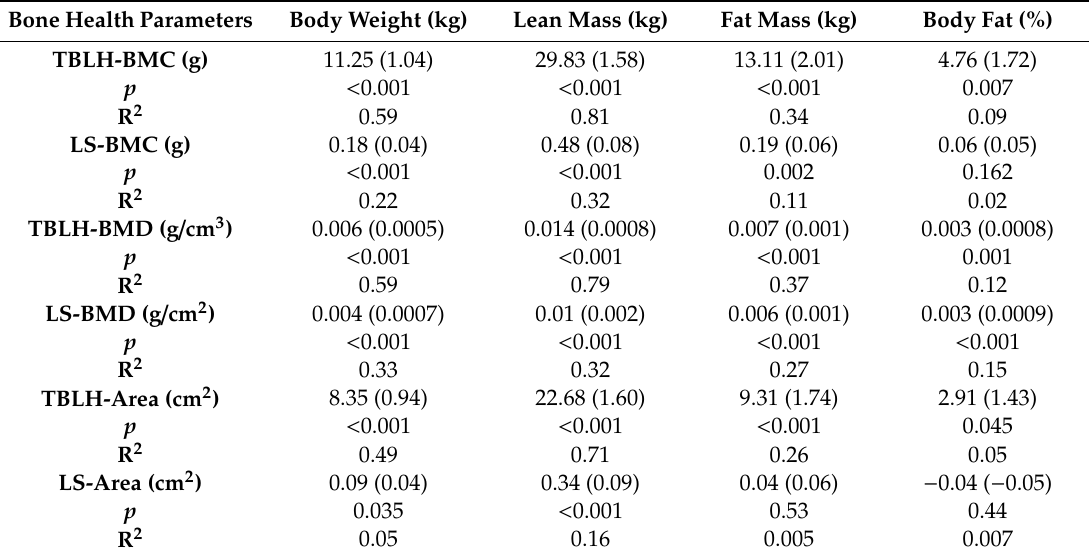
Table 2. Association between bone health parameters and body composition. Bone Health